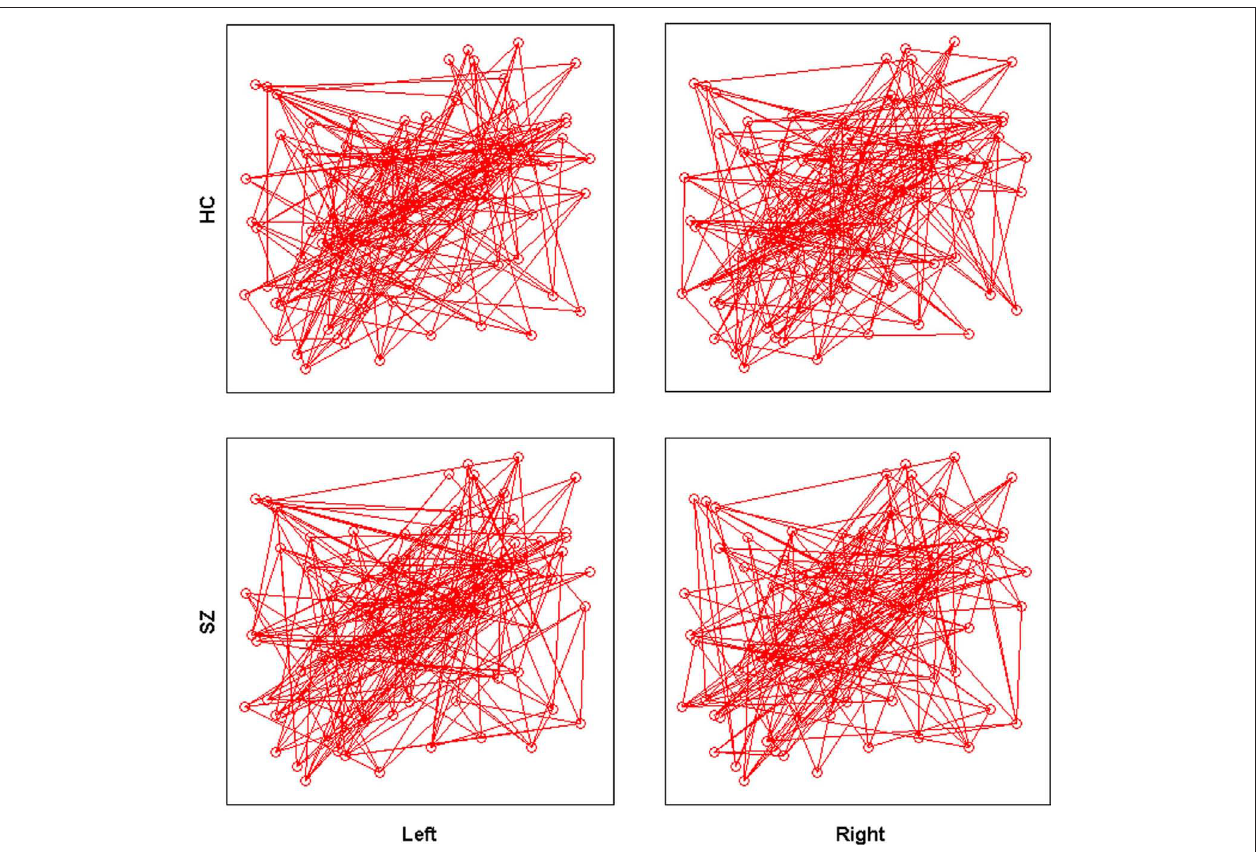
FIguRe A1 | graph of networks built from mean absolute z -score matrices for HCs and SZ at threshold T = 0.104. Red circles are nodes (voxels). Red lines are edges. Nodes are randomly organized but HCs and SZ have the same organization. Left: the left task-related network; Right: the right task-related network.